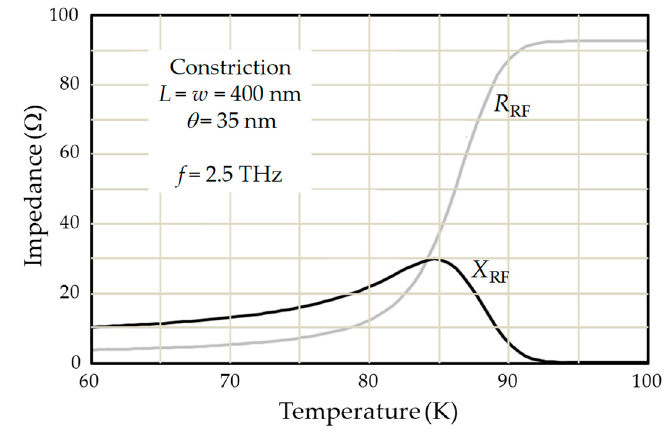
Figure 14. Example of the real and imaginary parts of a total THz impedance of a constriction; the temperature was assumed uniform in this case.